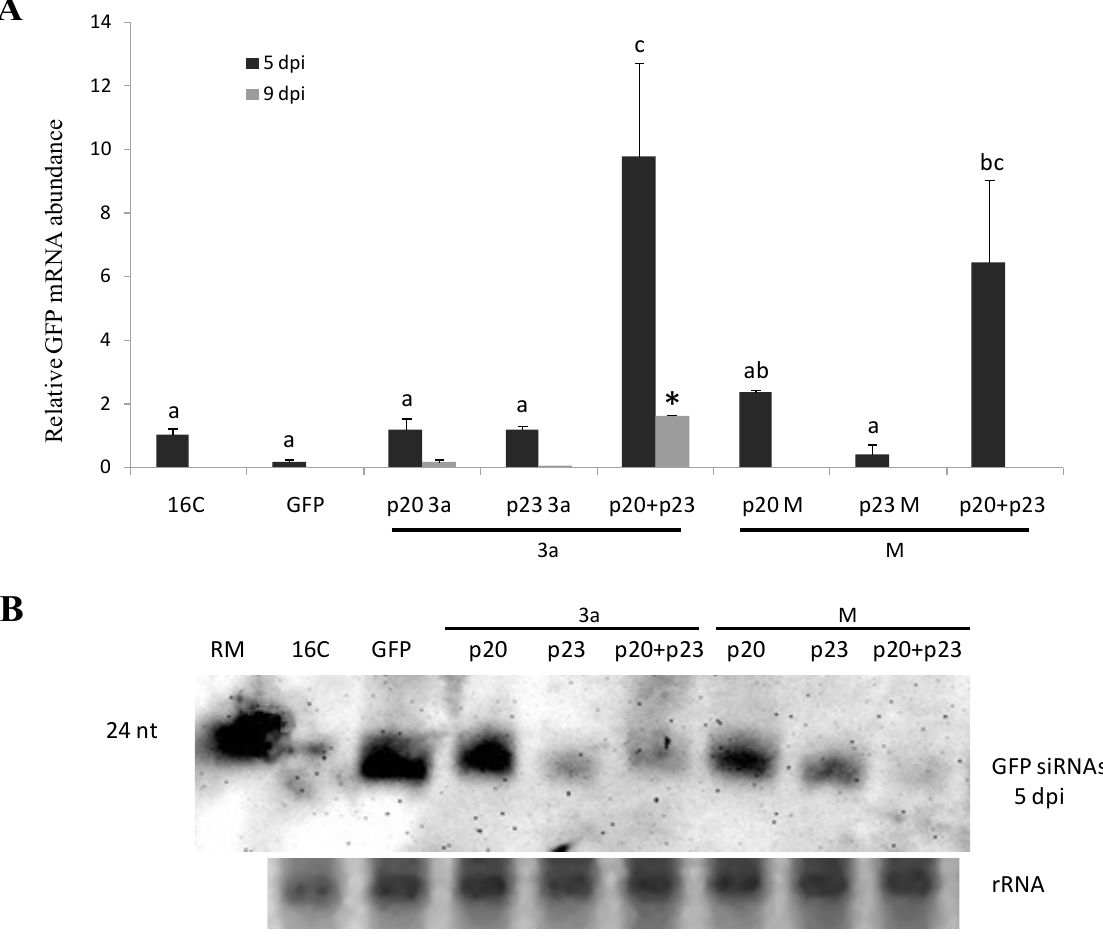
Figure 2. A. Relative levels of GFP mRNA in agro-infiltrated N. benthamiana 16C leaves at 5 and 9 dpi, determined by qRT- PCR and normalized against the levels of the ubiquitin gene. 16C: 16C non-inoculated plants, used as a reference to